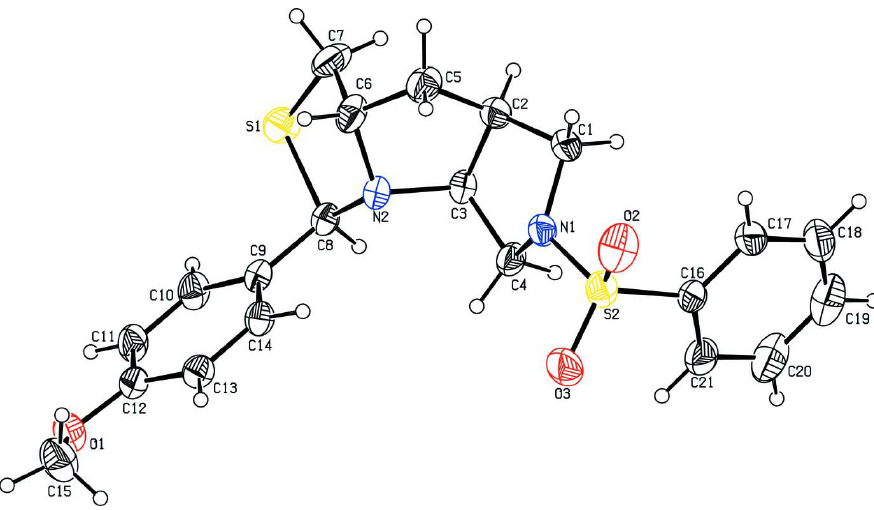
Figure 1 The molecular structure of the title compound, showing 30% probability displacement ellipsoids.